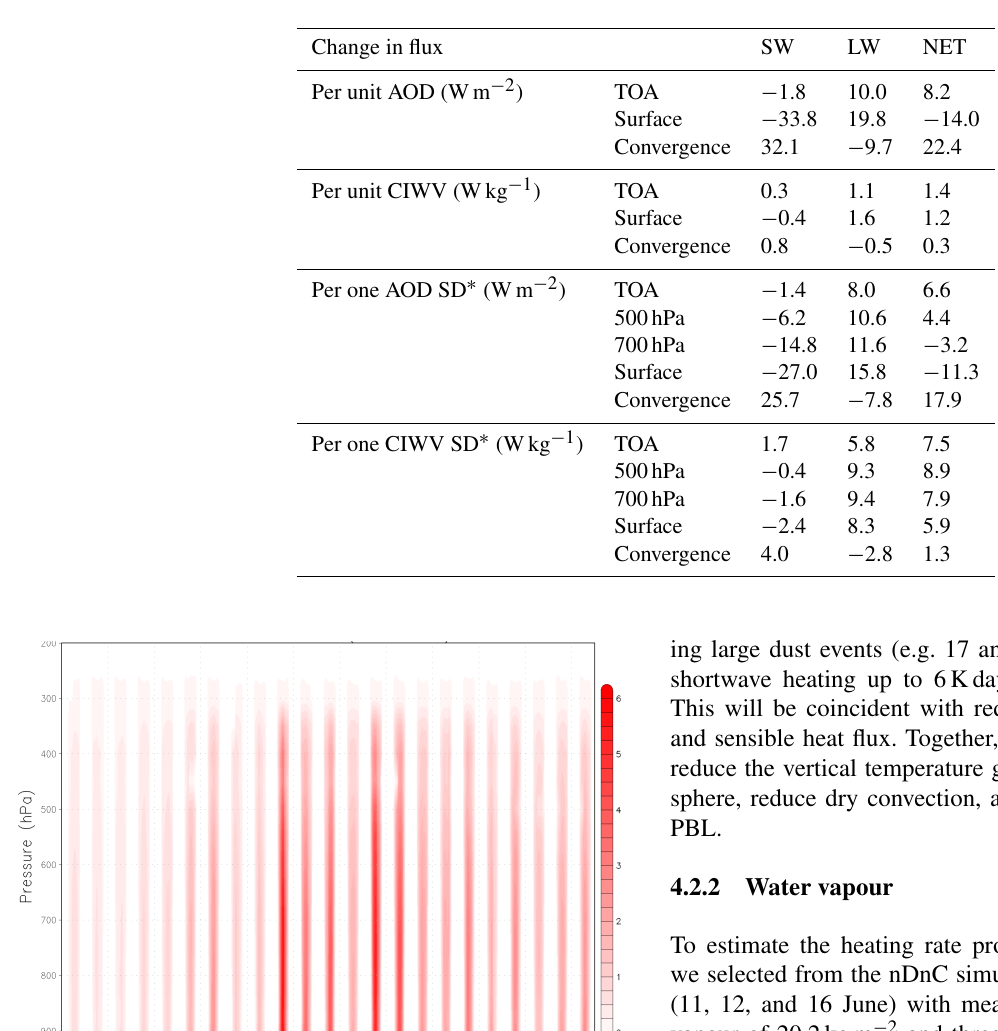
Table 4. Sensitivity of radiative flux to dust AOD and CIWV at selected altitudes. SD ∗ indicates standard deviation (0.8 for AOD and 5.5gkg − 1 for water vapour). Mean AOD is 1.2 and mean column-integrated water vapour is 27.8kgm − 2 .